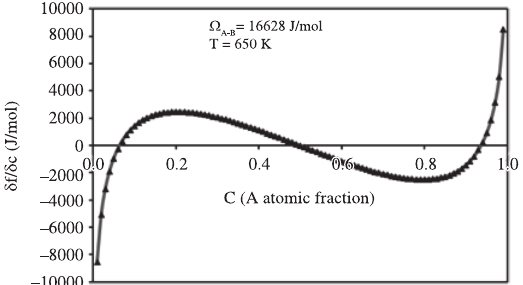
Figure 7. Concentration profile of the A-50at.%B alloy aged at 650 K for different times for Ω = 16628 J/mol with linear equation. A-B